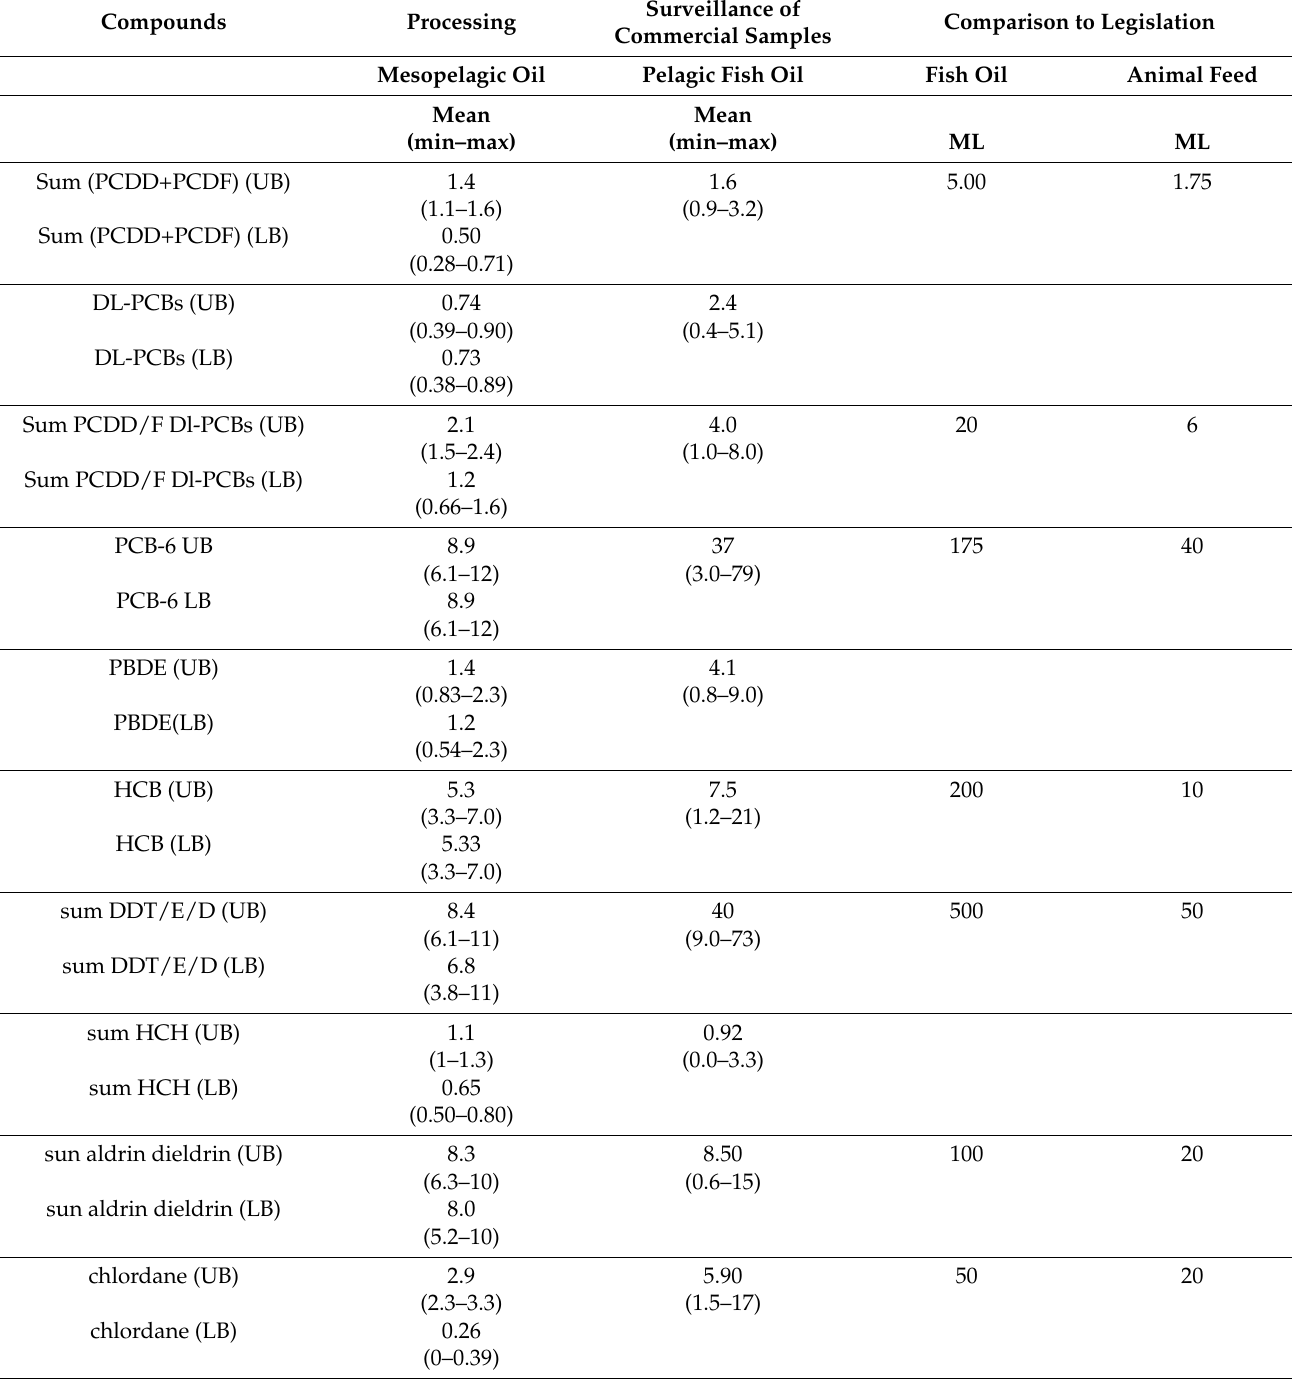
Table 3. Concentrations of dioxins (PCDD/F), dioxin-like PCBs (DL-PCBs) (WHO-TEQ pg g-1 per DW),